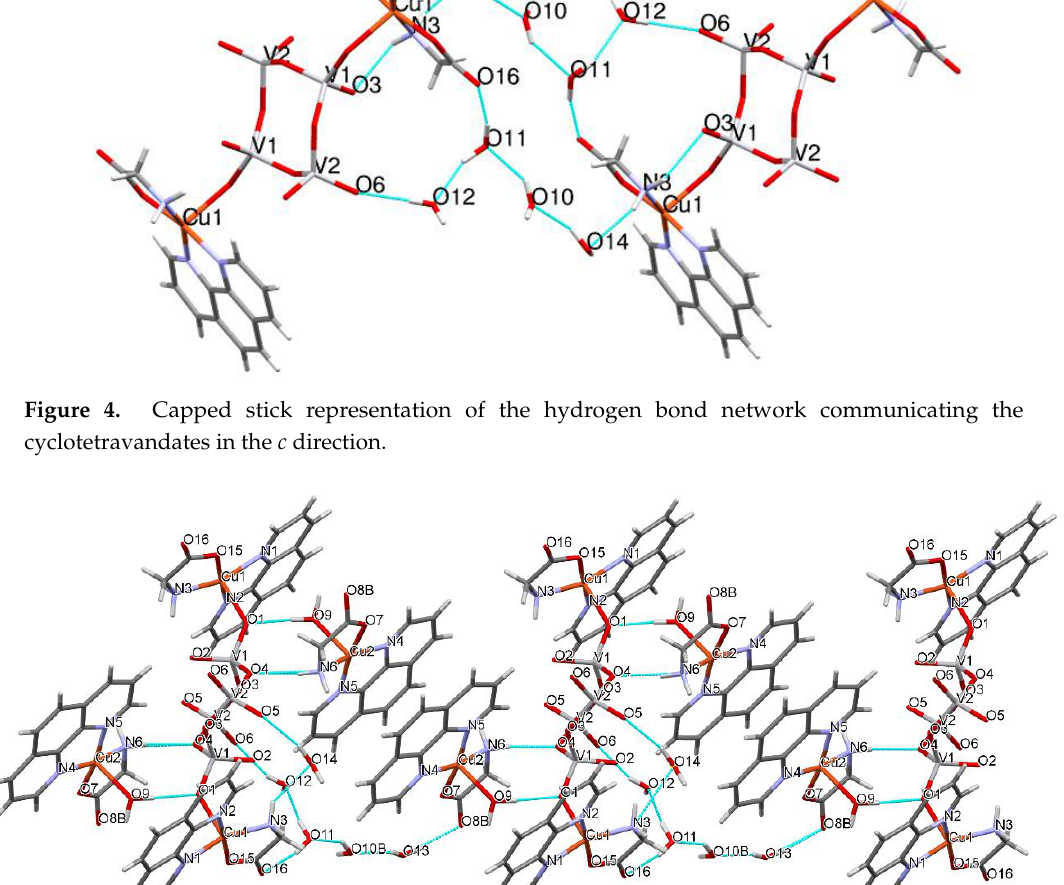
cyclotetravanadate units in a monodimensional supramolecular structure along the a-axis. Red arrows